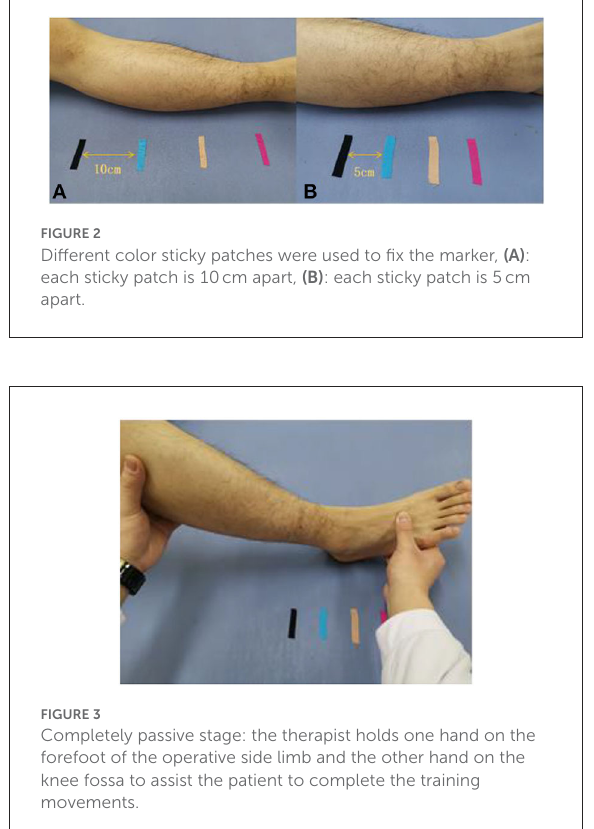
FIGURE3 Completely passive stage: the therapist holds one hand on the forefoot of the operative side limb and the other hand on the knee fossa to assist the patient to complete the training movements.